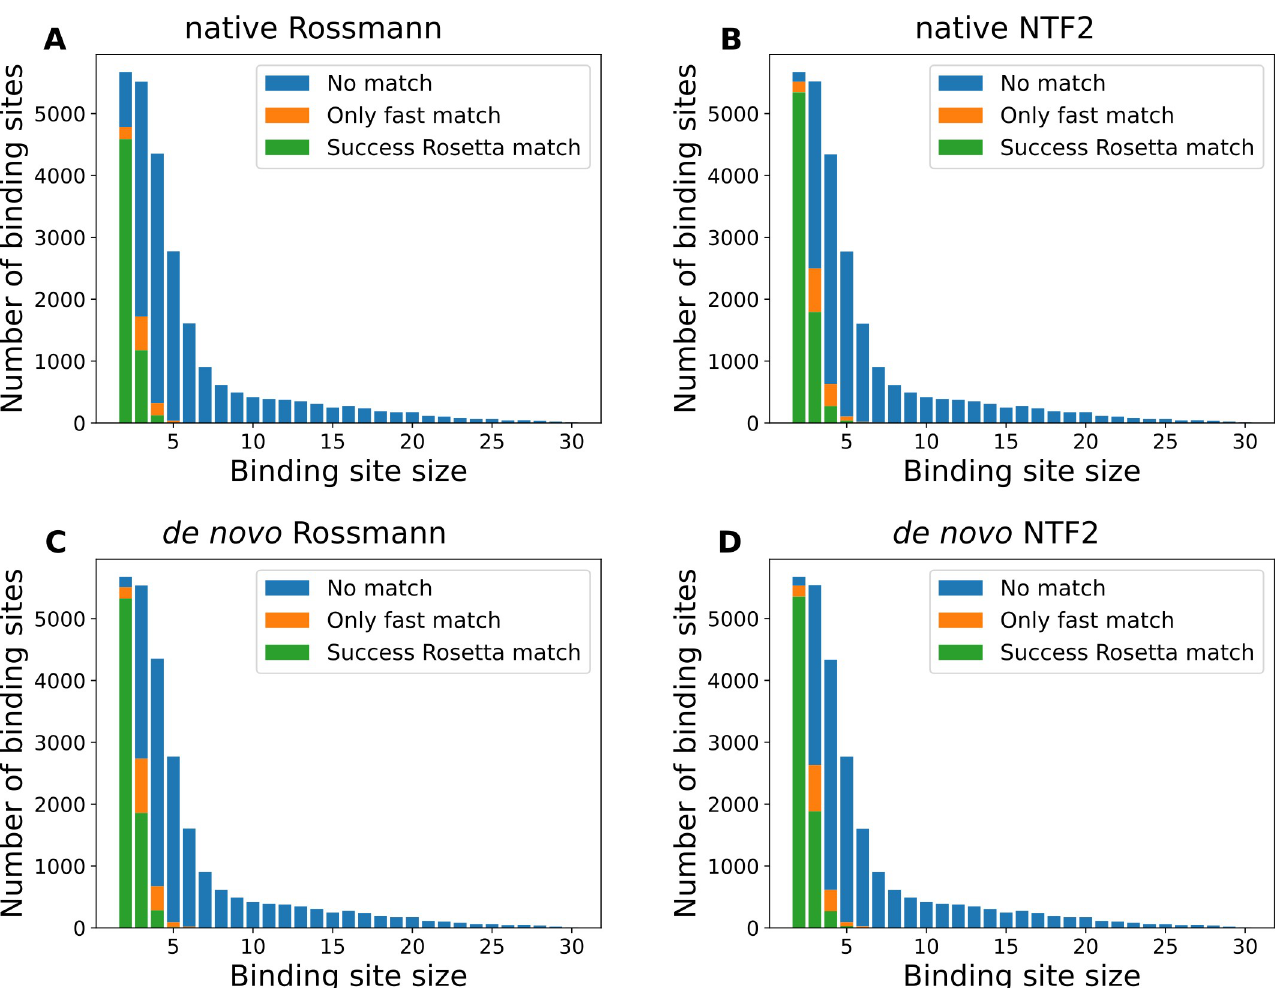
Fig 3. Matchability of ligand binding sites depends on the binding site size. Histograms of numbers of matches vs binding site sizes (number of protein residues in the binding site). Binding sites that cannot be matched to any scaffold are shown in blue. Binding sites that can be matched to at least one scaffold by the fast match method but cannot be matched by the standard Rosetta matcher are shown in orange. Binding sites that can be matched to at least one scaffold by the standard Rosetta matcher are in green. A-D. Results for 4 scaffold libraries; scaffold sets are indicated in each panel title.